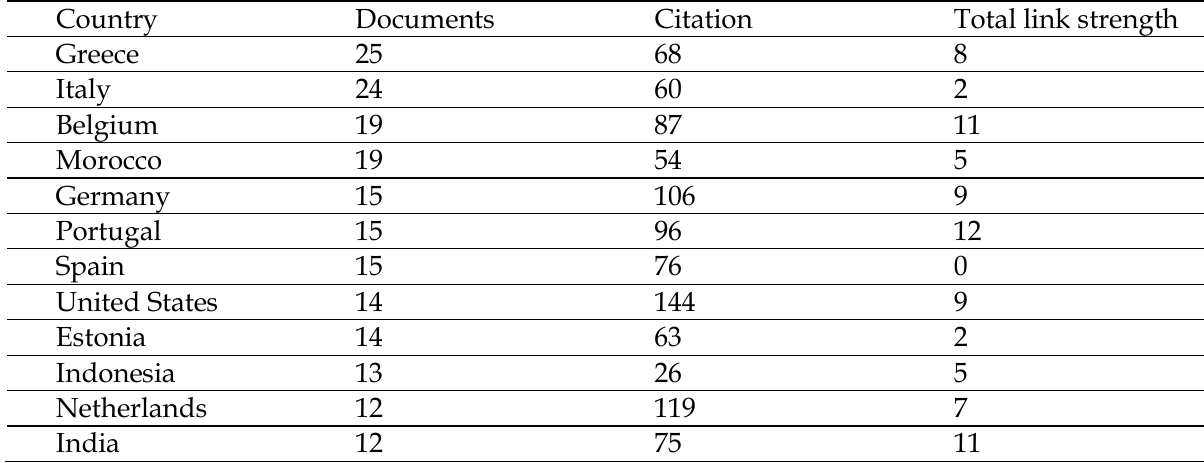
Table 2: Country Distribution by Document, Citation, and Link Strength Source: Scopus database. Country